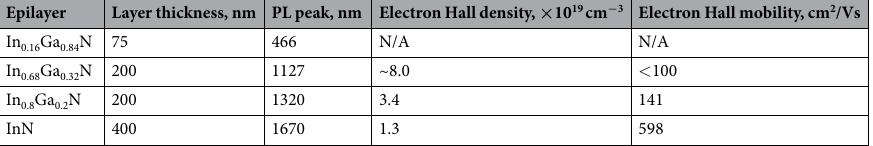
Table 1. Main parameters of the studied samples.